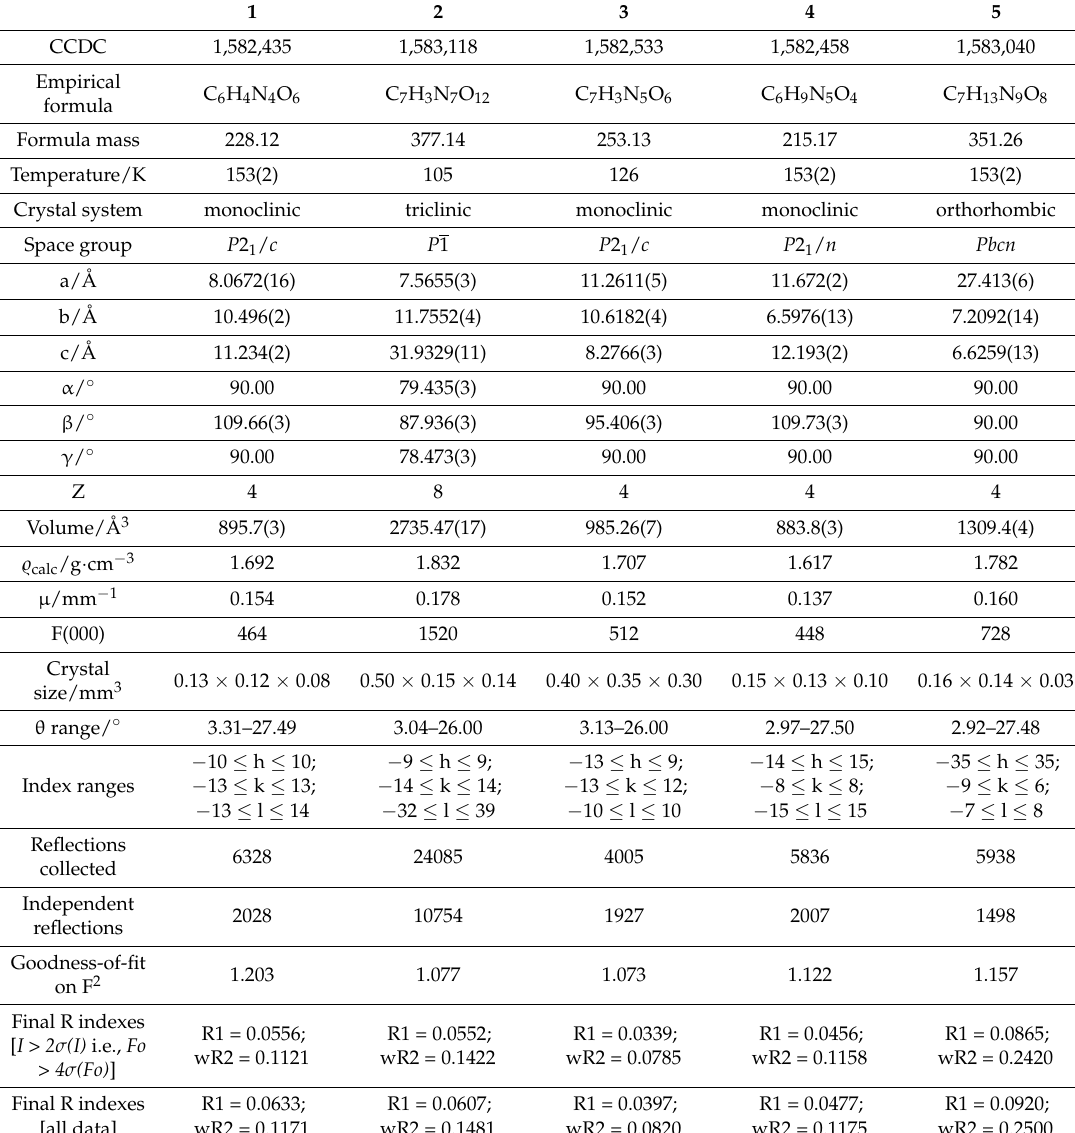
Table 1. Crystallographic data for 1 , 2 , 3 , 4 and 5